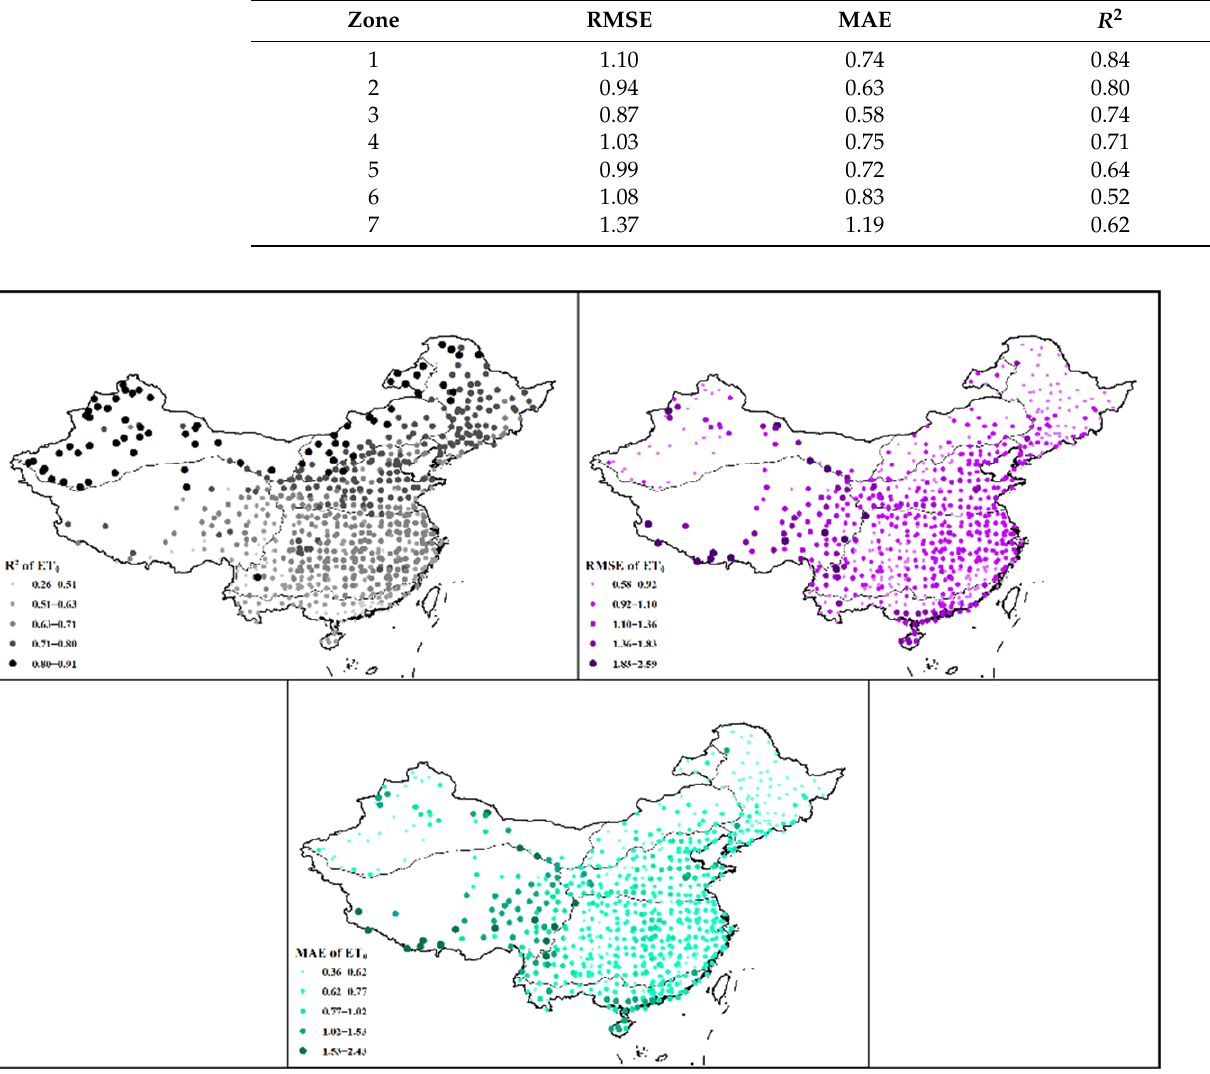
Table 4. Statistical indicators of reference evapotranspiration in different climate zones of China.